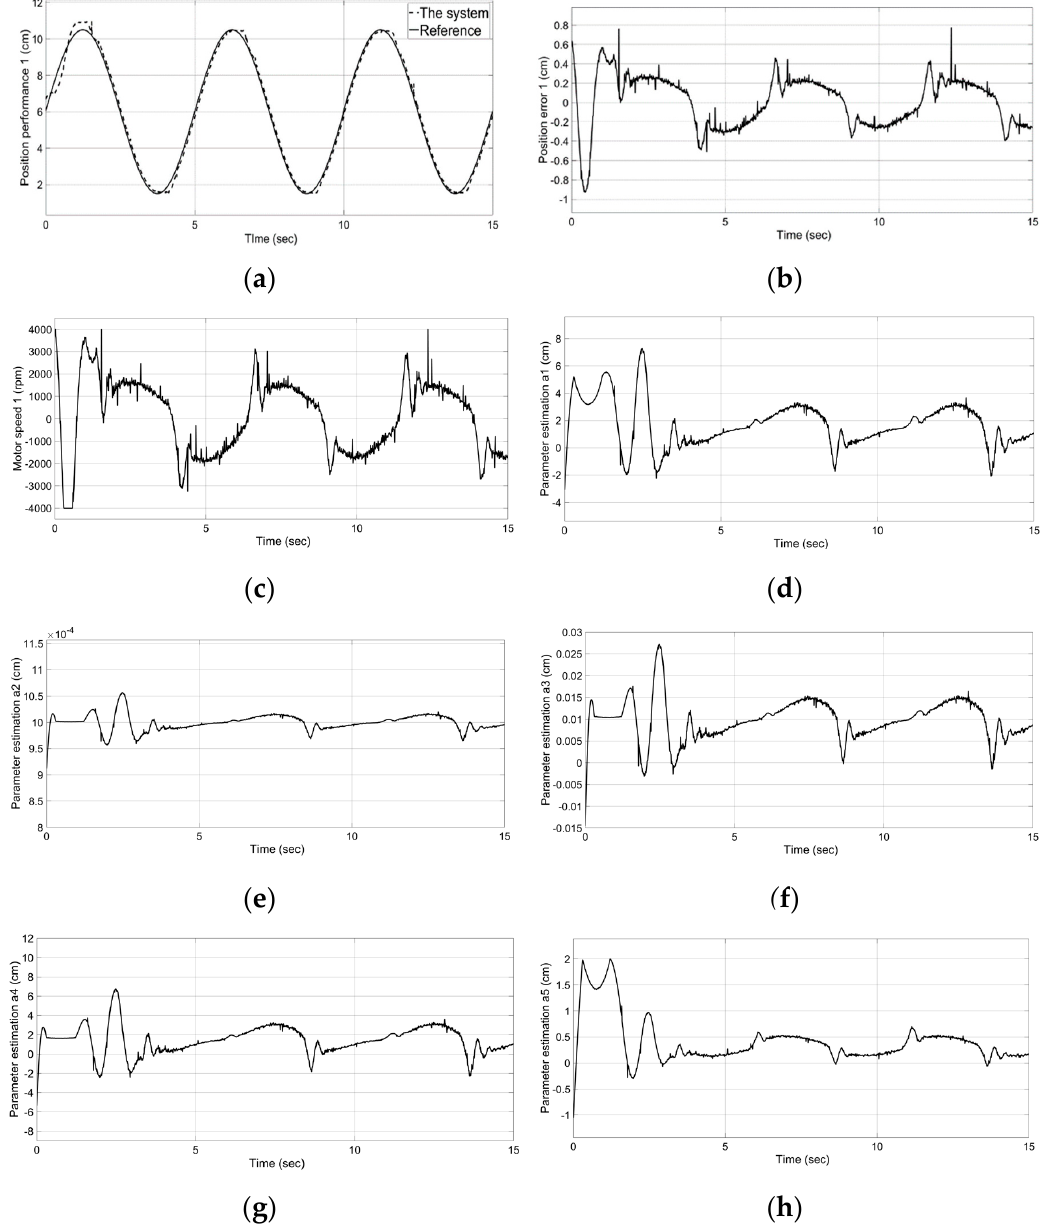
Figure 7. Experimental tracking responses without a load: ( a – c ) describe the EHA position performance in cm, the tracking error in cm, and the rpm of the motor; ( d – h ) are the estimation parameters in